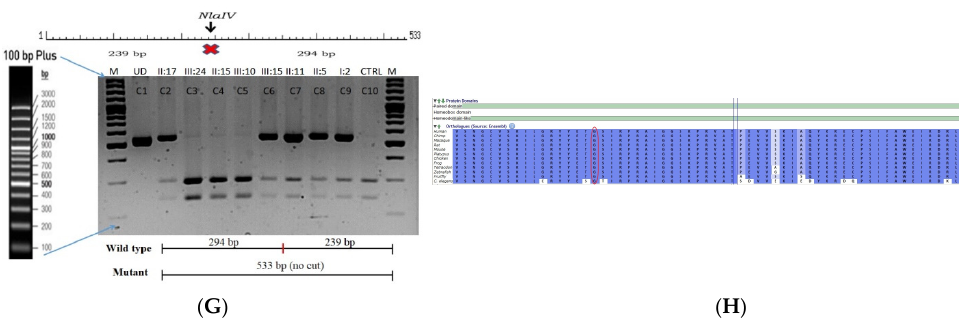
Figure 2. Pedigree of C343 ( A ). Partial sequence chromatogram of C343 family members, PAX6 exon 7, depicting a heterozygous mutation (c.233 G > T; p.G78V) in the proband’s father (( B ), II:17) and control subject ( C ). Mutant and wildtype peaks “T” and “G” are marked by an arrow. Missense mutation (in red) compared with the wildtype sequence (in green) ( D ). Model structure representing wildtype ( E ) versus mutant ( F ) PAX6. The mutated amino acid is highlighted in red, while its interacting amino acids nearby are marked in a white and blue combination. The mutated amino acid hinders the exposure of neighboring residues such as threonine at position 77 and tyrosine at position 75 and, also, alters other interactions, which might affect its interaction with its downstream targets. RFLP analysis of the mutation p.G78V in PAX6 ( G ), which shows co-segregation of the heterozygous mutation among affected family members (C2 and C6-C9). Unaffected family members (C3-C5) and control (DKC192) (C10) show complete digestion. C1 — undigested PCR product. Amino acid sequence alignment of human PAX6 and orthologs from other species ( H ), showing the conservation of p.G78 (encircled in red). Divergent amino acid residues are shaded in a white background.